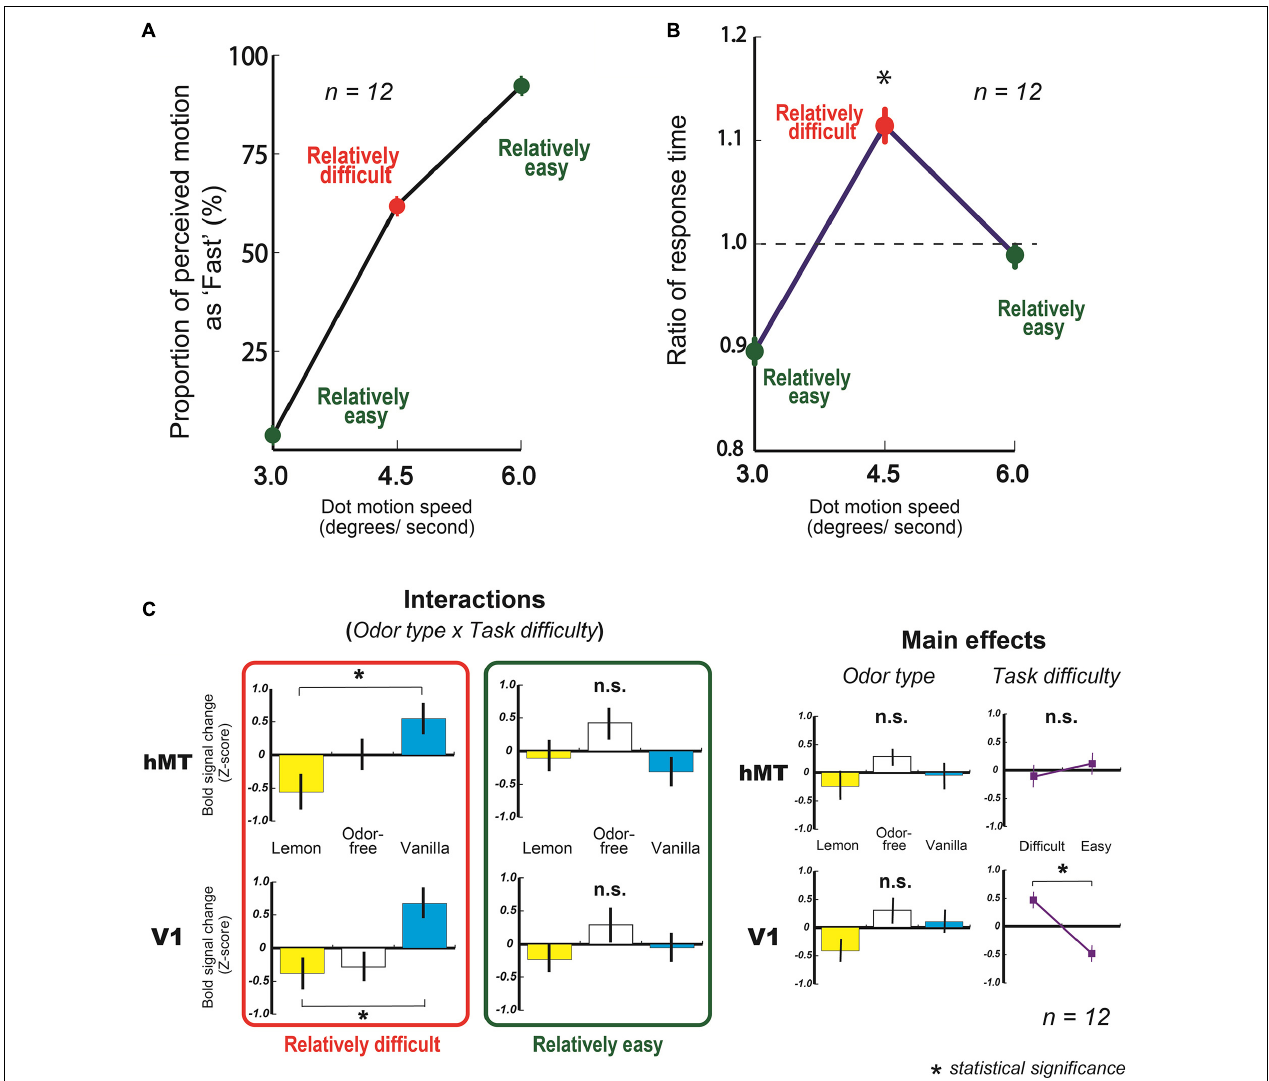
FIGURE 4 | Results of fMRI experiments. (A) Mean behavioral response of fast (%) as a function of dot speed (degrees/s). (B) Mean ratio of response time in fMRI experiment as a function of dot speed (degrees/s). A dashed line represents averaged ratio of response time at all dots speed condition (1.0 here, also see section “Materials and Methods”). The ratio of response time at 4.5 degrees/s condition was significantly higher than at 3.0 and 6.0 degrees/s. (C) Averaged blood oxygen level-dependent (BOLD) signal changes (Z-score) in V1 and hMT with three types of odor, lemon, odor-free, and vanilla. Error bars show standard